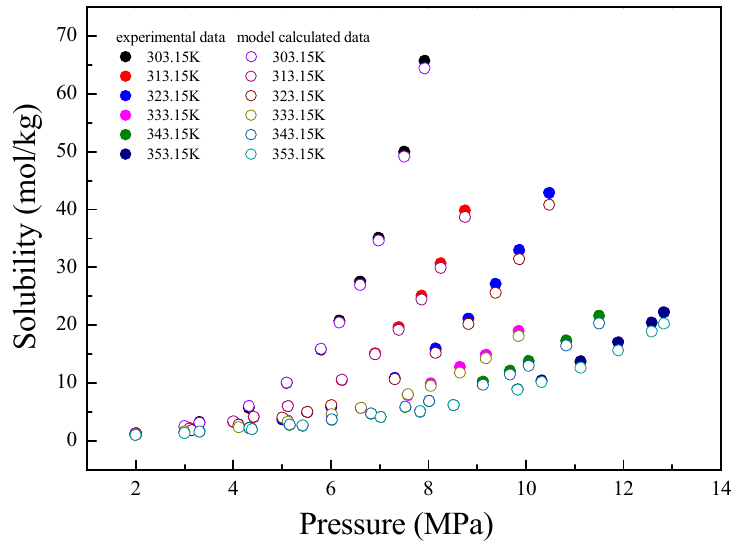
Figure 6. Comparison between experimental data and model calculated data of the solubility of CO 2 in n -decane + n -hexane system.